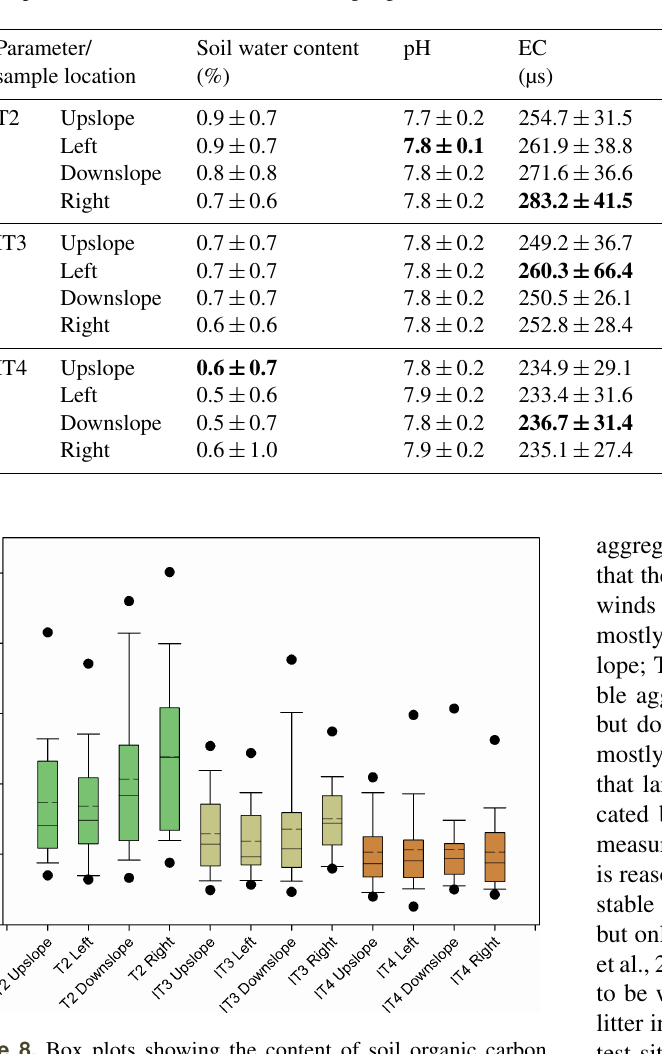
Table 3. Average values ± SD (standard deviation) for all parameters for each sample location in slope direction. T2 – near tree drip line and within tree area; IT3 – near tree drip line and outside tree area; IT4 – intertree area between two trees; EC – electrical conductivity; PS – percolation stability; TN – total nitrogen content; SOC – content of soil organic carbon; C / N is the C / N ratio. The singular highest values for each parameter for T2, IT3 and IT4 are highlighted bold.